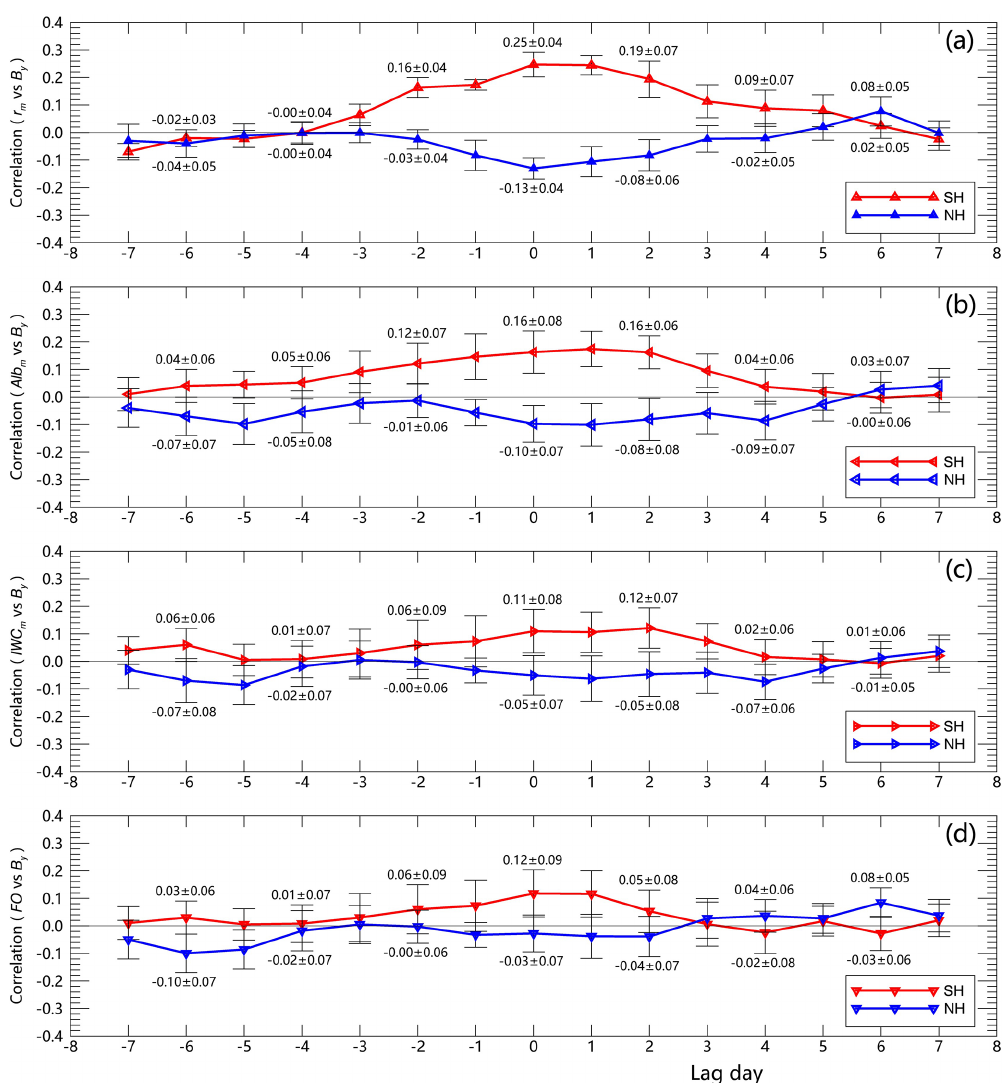
Figure 4. Correlation coefficients between the anomaly of r m , Alb m , IWC m and IMF B y for time lags varying from − 7 to 7d, with red and blue lines representing the mean correlation coefficients and error bars illustrating the standard deviation of the mean for the SH and NH,